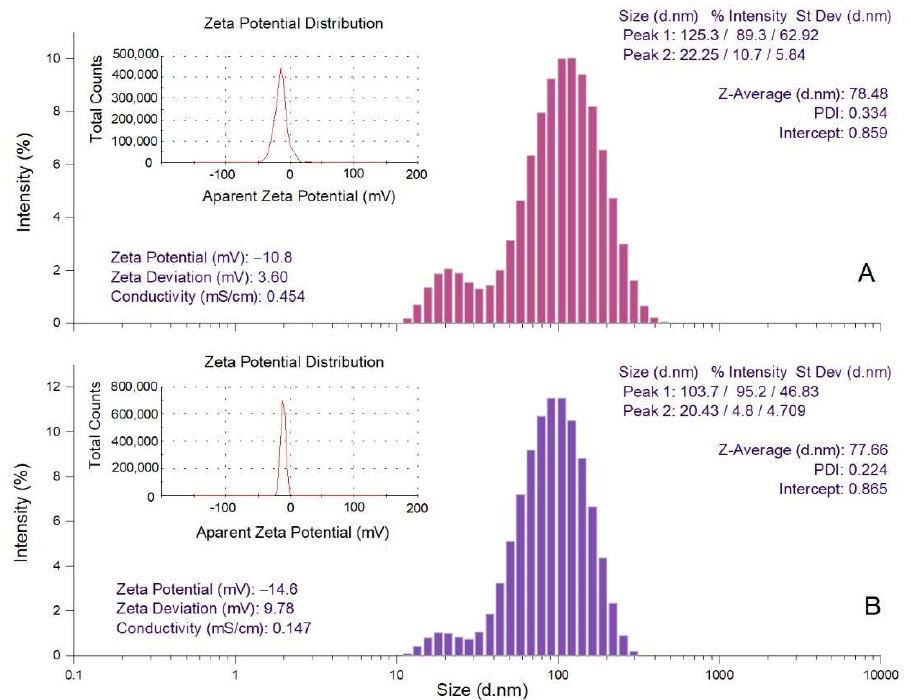
Figure 5. DLS analysis of Picea abies ( A ) and Pinus nigra ( B ) bark extract derived AgNPs (Z-average— hydrodynamic diameter; PDI—polydispersity index; d.nm—diameter in nm).